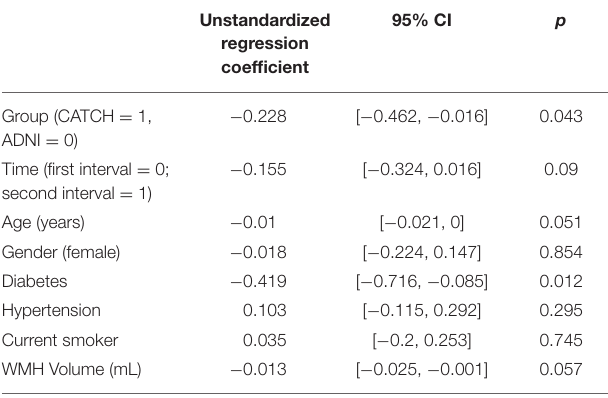
TABLE 1 | Demographic and medical characteristics of TIA and minor stroke patients and healthy controls. Characteristics